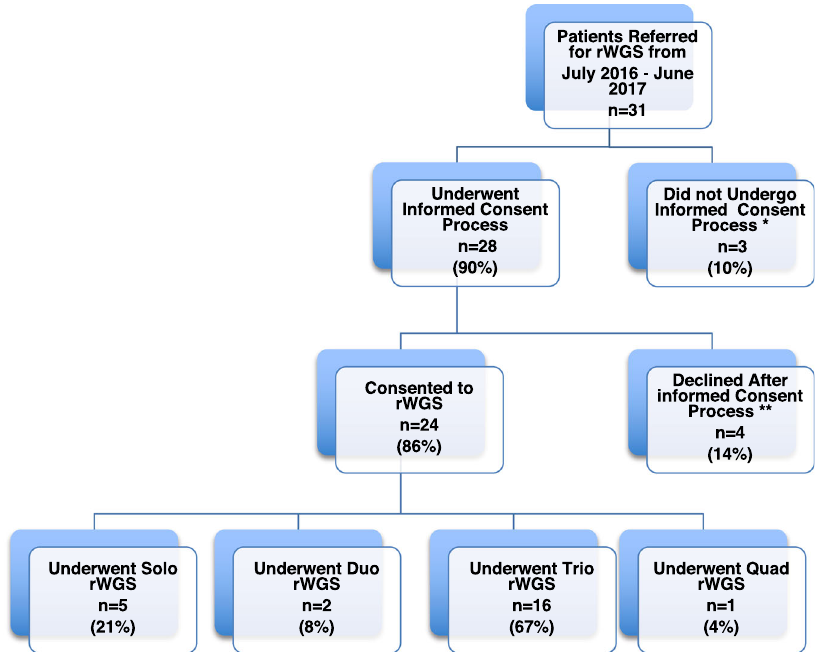
Fig. 1 Flow diagram of families referred for rWGS and the rate of consent to the study. Eighty-six percent of families who underwent the informed consent process enrolled in the rWGS study. *Three families did not undergo informed consent process (one maxed out on number of contact attempts per research protocol, two for unknown reasons). The majority of families underwent trio rWGS (67%). **Four families declined participation after informed consent process: two secondary to concerns for lack of protection under GINA (Genetic Information Nondiscrimination Act of 2008, Pub. L. 110 – 233, 122 Stat. 881), one wanted more than just phenotype driven genetic information, and one did not follow up after consent